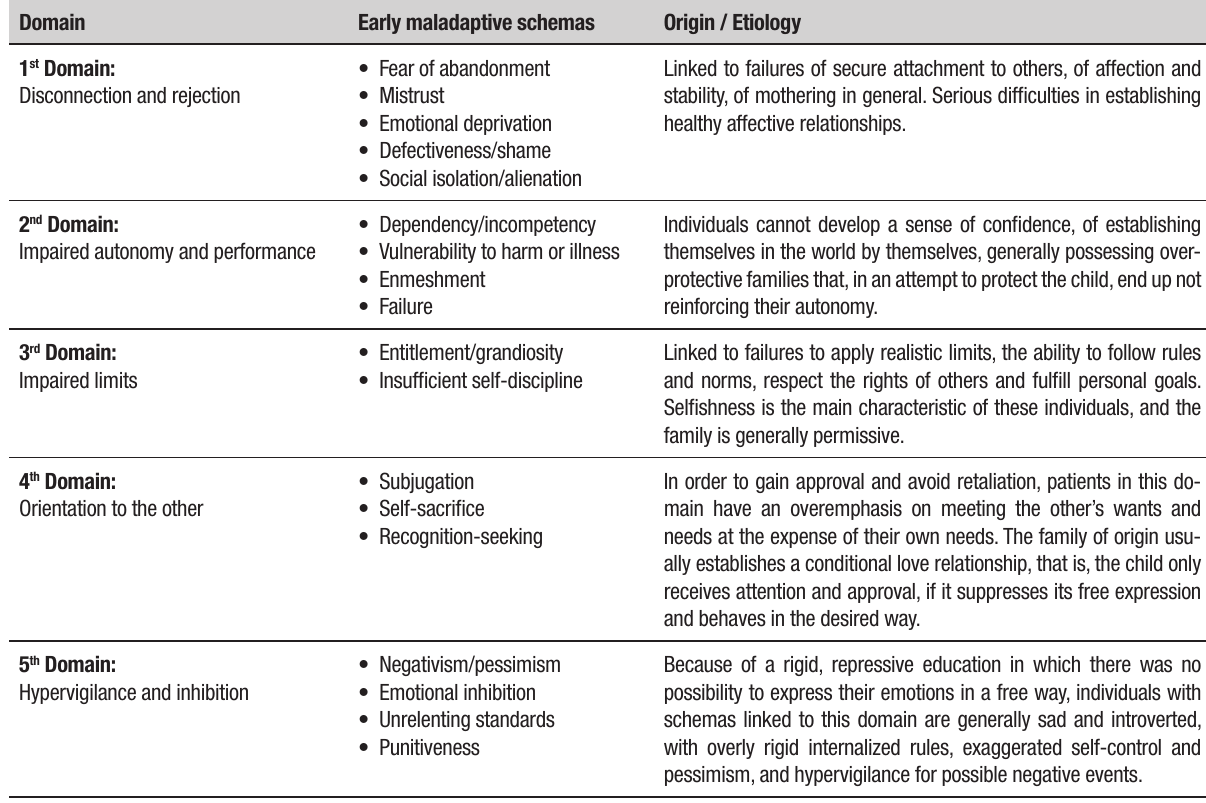
Table 1. Association between morbidity, gender and age group.